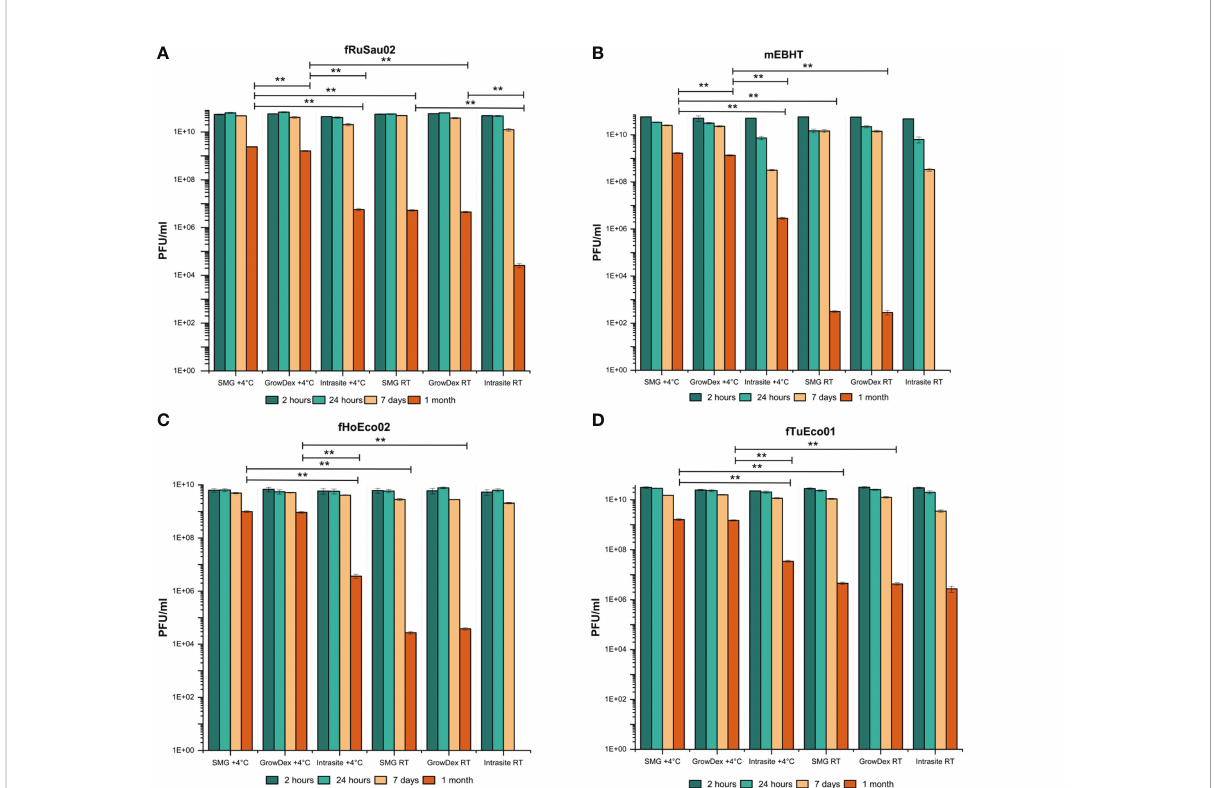
FIGURE 4 Comparison of Intrasite and GrowDex hydrogels as phage matrix. Phages fRuSau02 (A) , mEBHT (B) , fHoEco02 (C) and fTuEco01 (D) were stored with Intrasite and GrowDex-hydrogels at RT and 4°C in 2 ml tubes for up-to one month. Phage stability in hydrogels was assayed by titration with double-layer agar method after 2 and 24 hours, 7 days, and 1 month of storage. Bars and error bars indicate mean of three independent titrations and SD, respectively. The statistical analysis of one-month titers was made by one-way ANOVA test (** p ≤ 0.01). For phages mEBHT and fHoEco02, one-month result (no plaques) at RT in Intrasite was not included in statistical